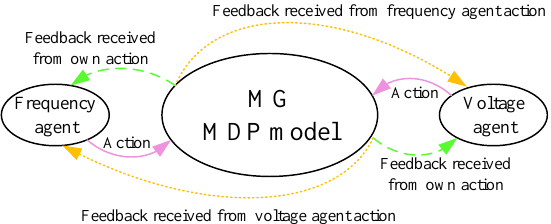
Figure 5. The proposed game-theory based reinforcement learning (RL) framework description considering the frequency and voltage